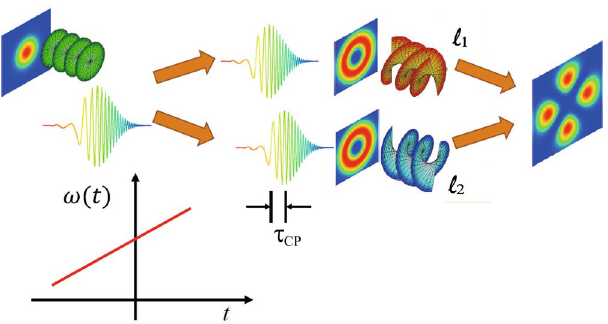
Figure 1. Schematic drawing of ultrafast spatial mode modulation by using chirped pulses of structured light (the case of the superposition of two OVs). τ CP : delay time between chirped pulses, ω( t ) : instantaneous frequency, ℓ 1 , ℓ 2 : topological charges of